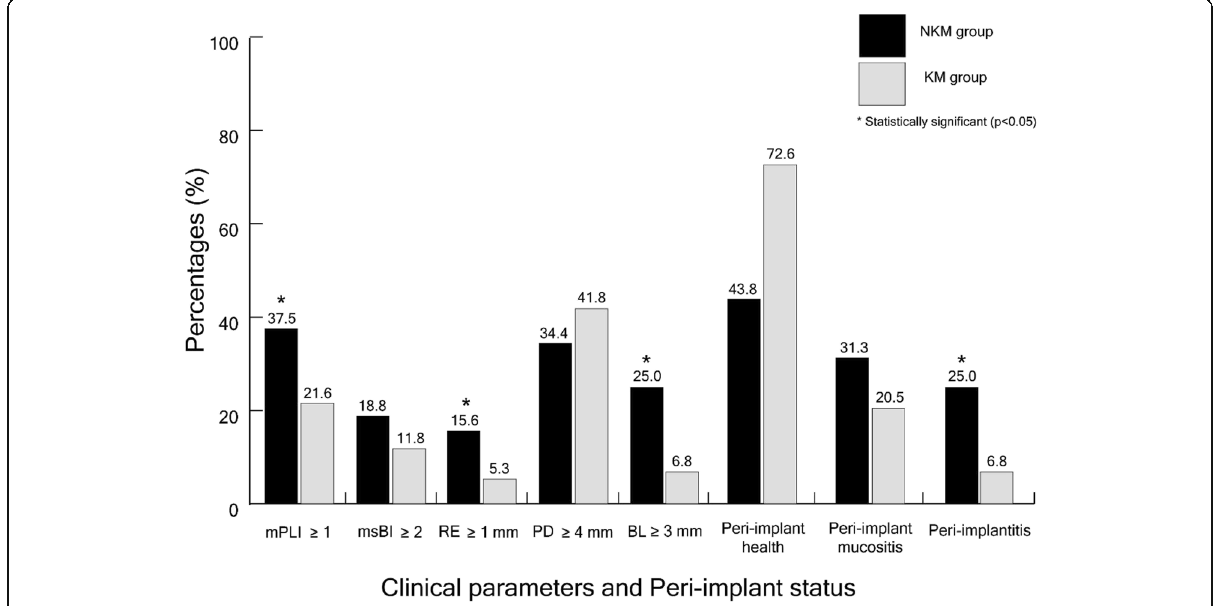
Fig. 1 The association between the presence or absence of keratinized mucosa and clinical parameters and peri-implant